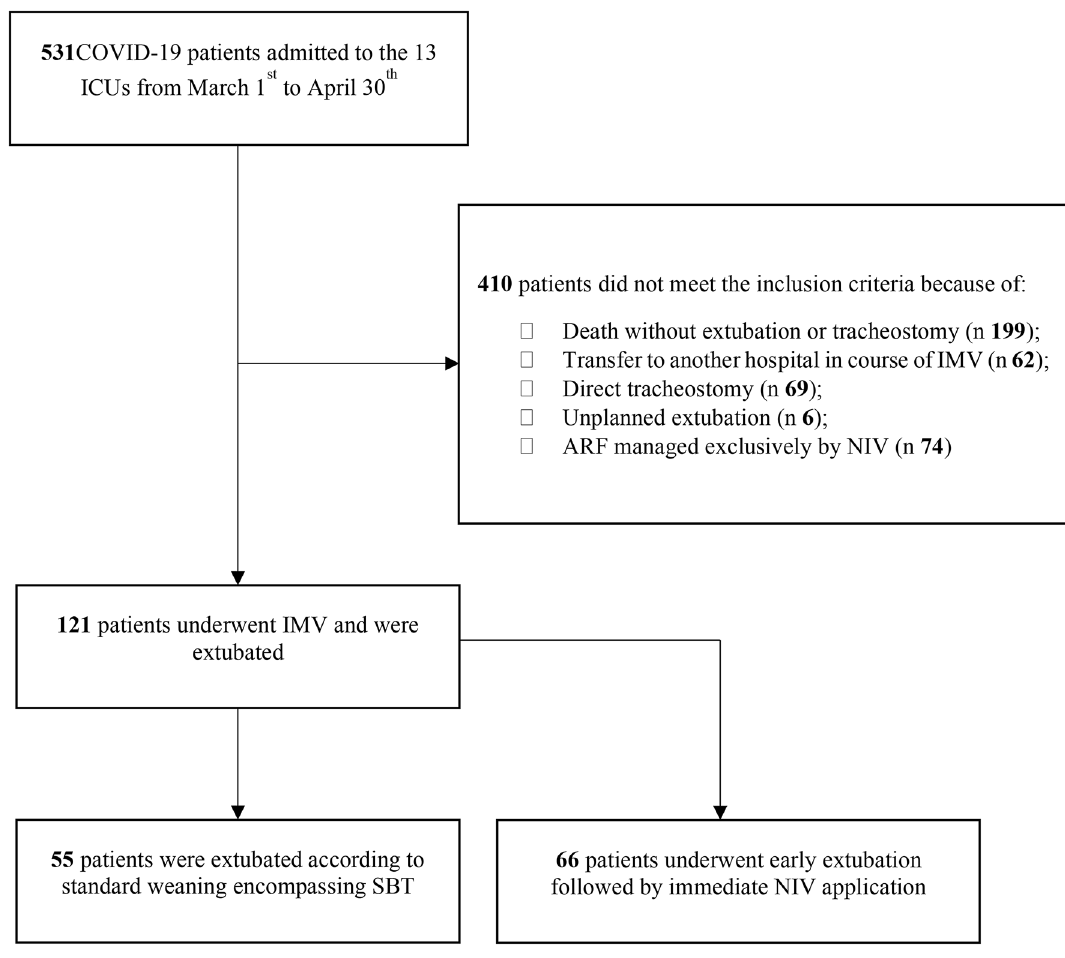
Figure 1. Study flow chart. COVID-19, coronavirus disease 2019; ICU, intensive care unit; ARF, acute respiratory failure; NIV, non-invasive ventilation; IMV, invasive mechanical ventilation; SBT, spontaneous breathing